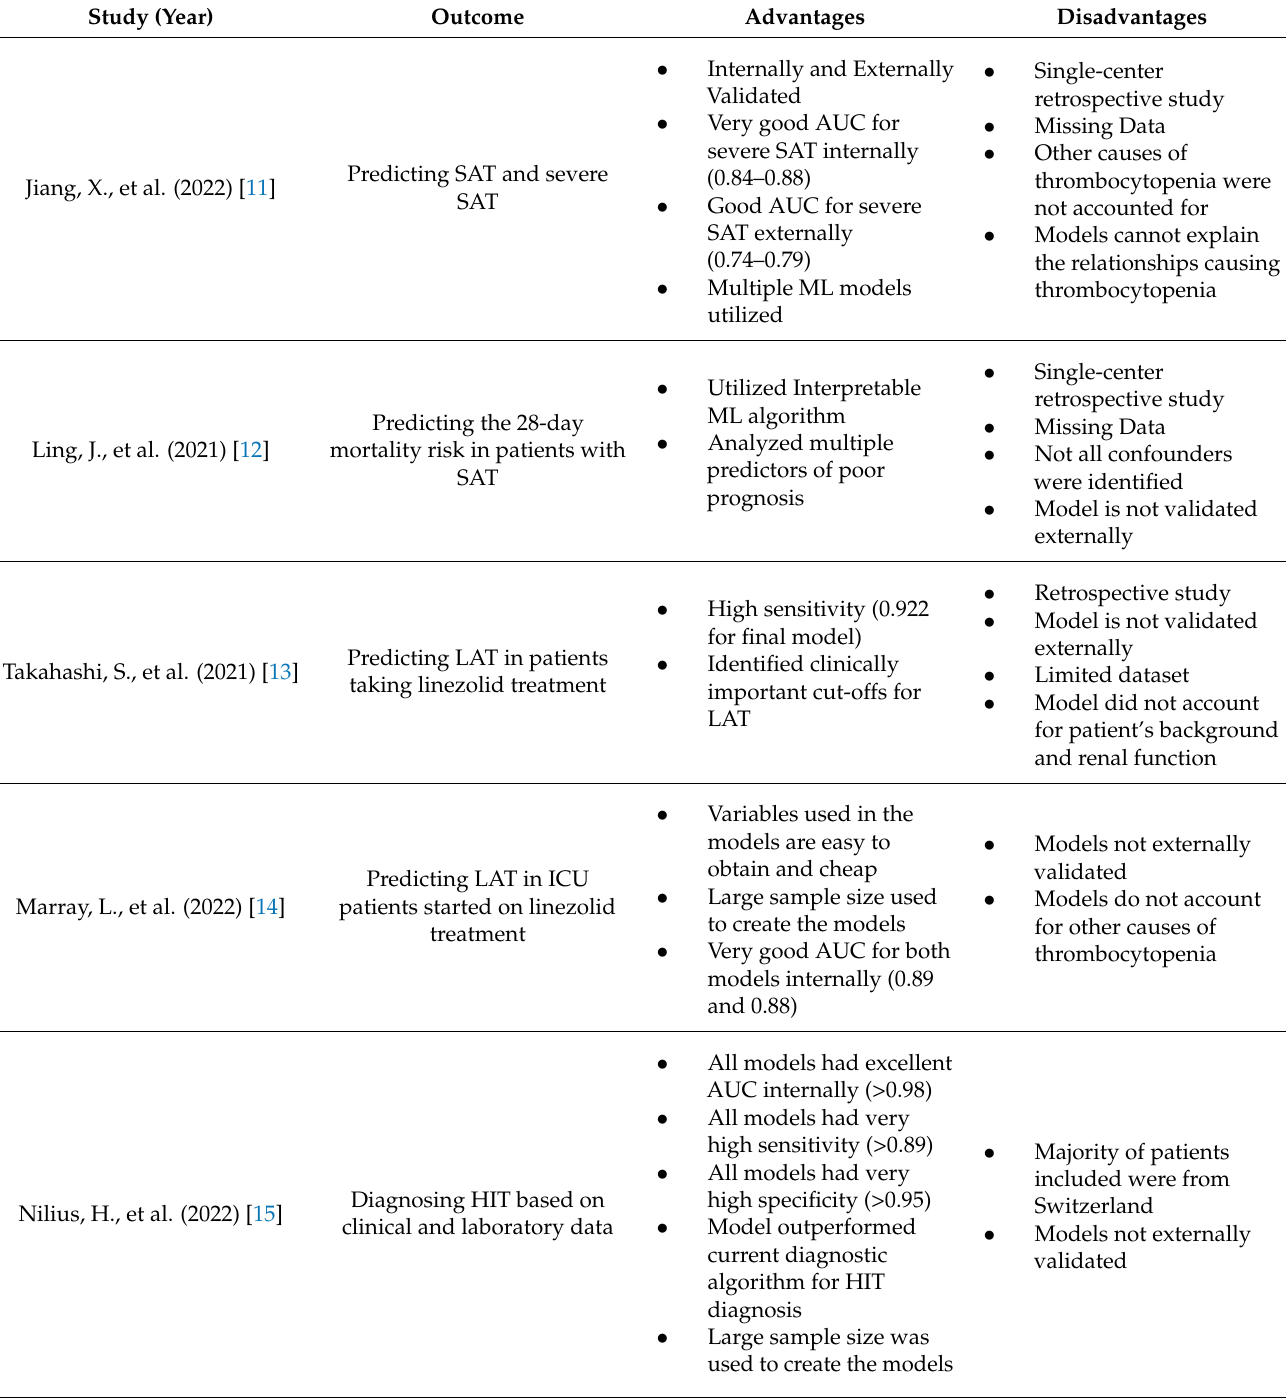
Table 1. Data extraction summary for full-text articles